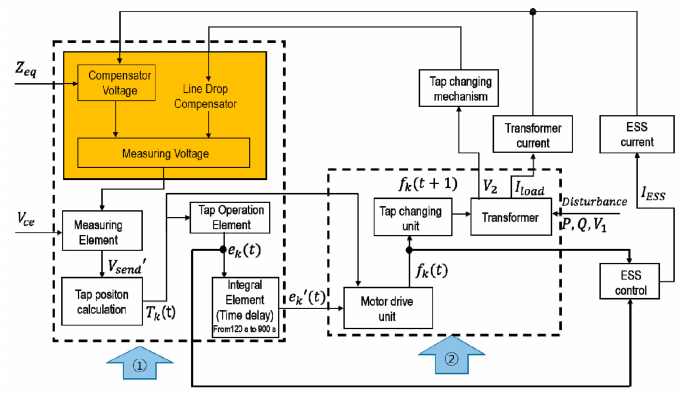
Figure 10. Operation block diagram of